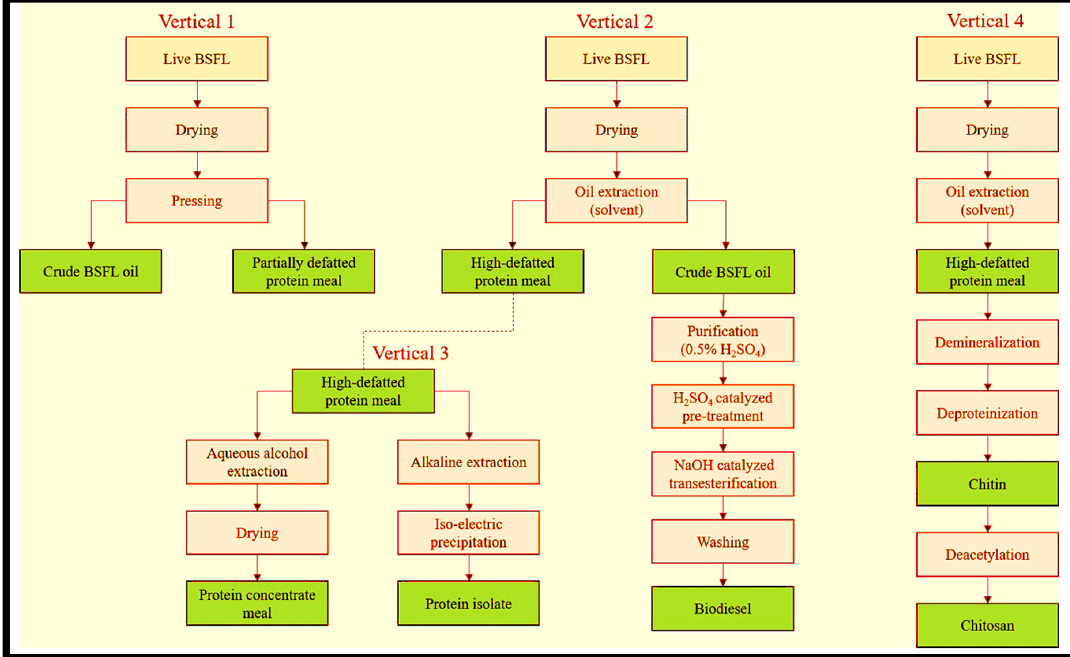
Figure 8. Flow chart of BSFL oil, protein, biodiesel and chitin extraction.